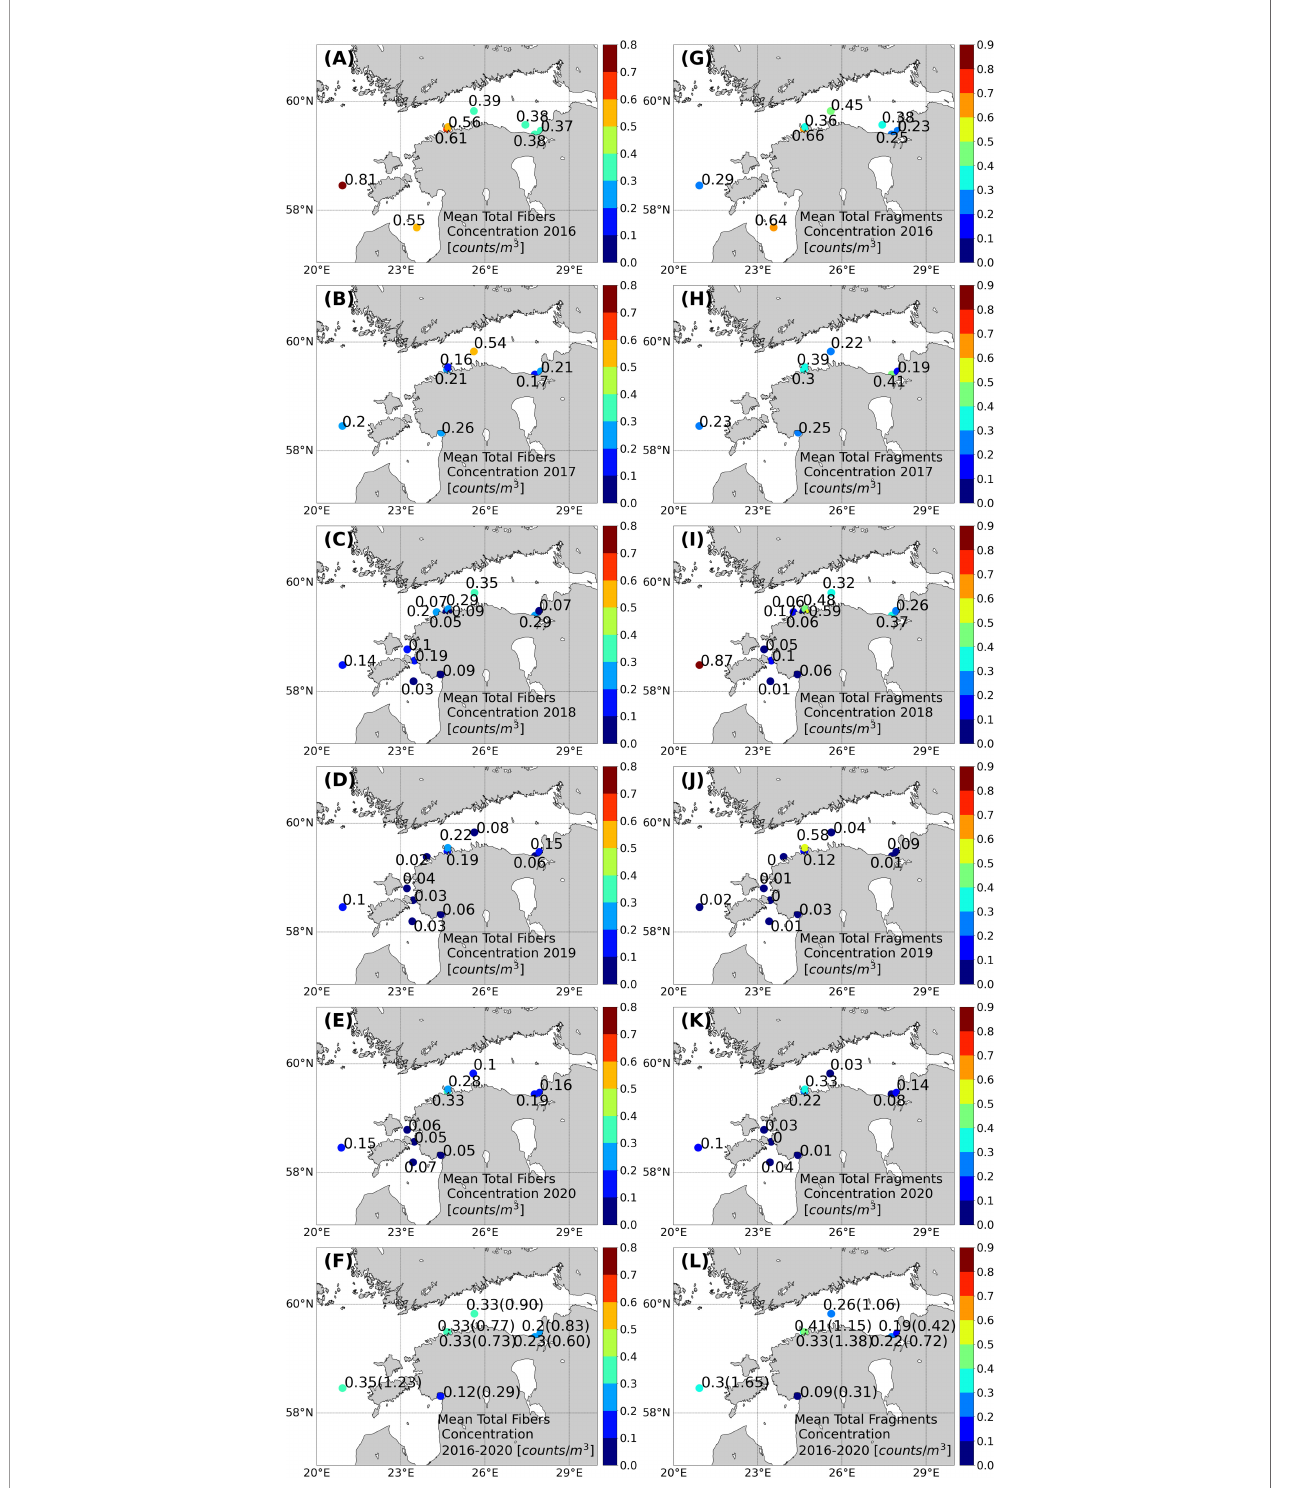
FIGURE 5 | Average MP fi ber counts/m 3 (A – F) and average MP fragment counts/m 3 (G – L) at each sampling station. The overall average for 2016 – 2020 was calculated as an arithmetic mean of all individual concentrations in the sampling location (F, L) . The highest MP fi ber and MP fragment concentration (counts/m 3 ) at the sampling station is shown in parentheses (F, L)